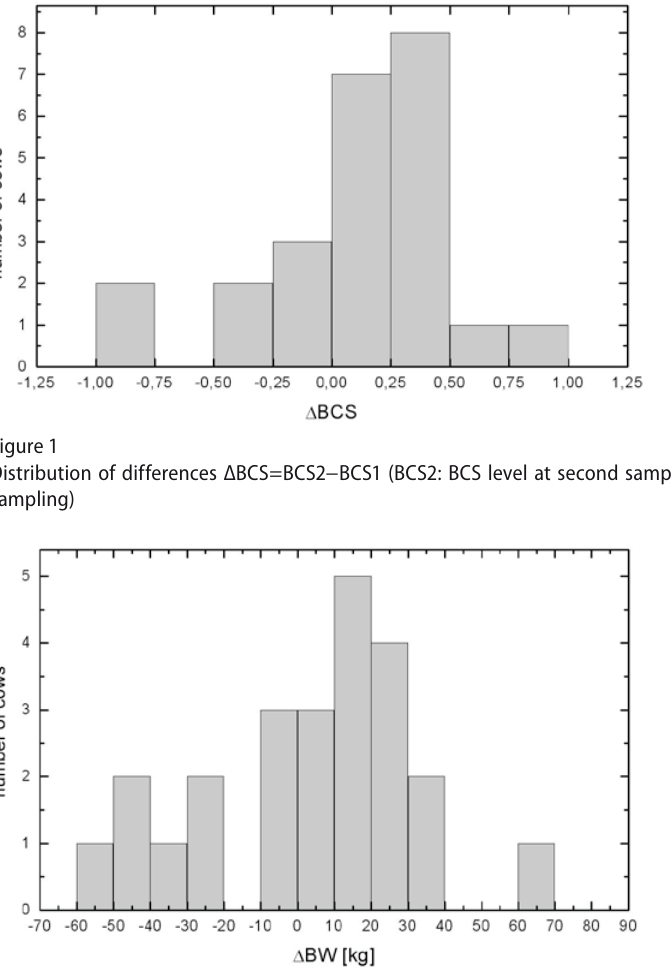
Figure 2 Distribution of differences ΔBW=BW2−BW1 (BW2: body weight at second sampling, BW1: body weight at first sampling) 8